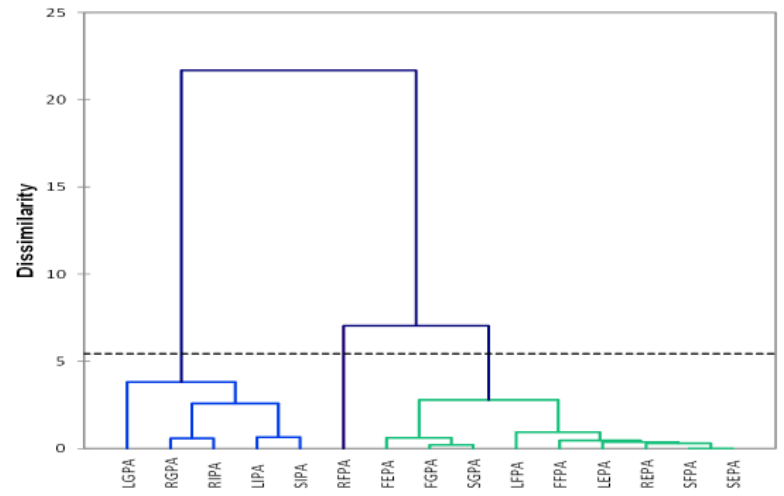
Figure 2. The dendrogram of extractable and non-extractable phenolics in the fruit, leaves, stem, and root of T. sericea.